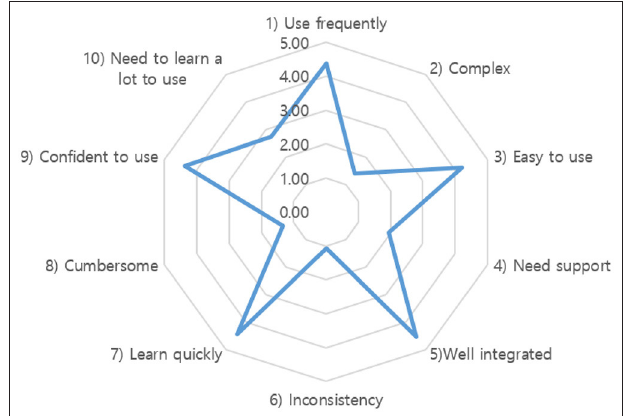
FIGURE 6 | Results of the mean score of each assessment item in system usability scale